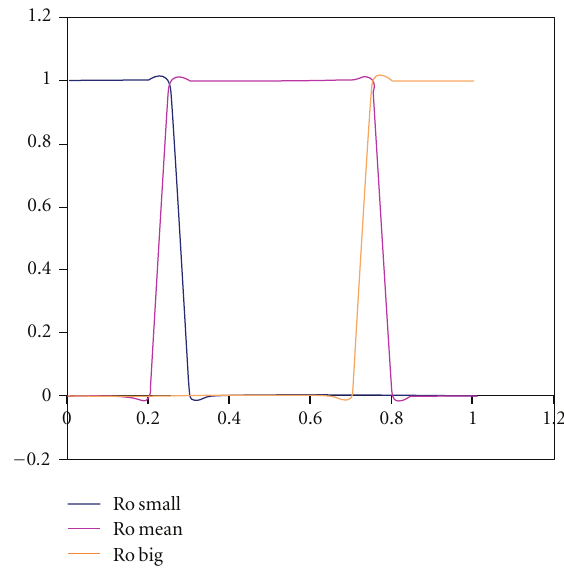
Figure 7: Ro small, Ro medium, and Ro big ( a = 0 . 49, b = 0 . 5, c =